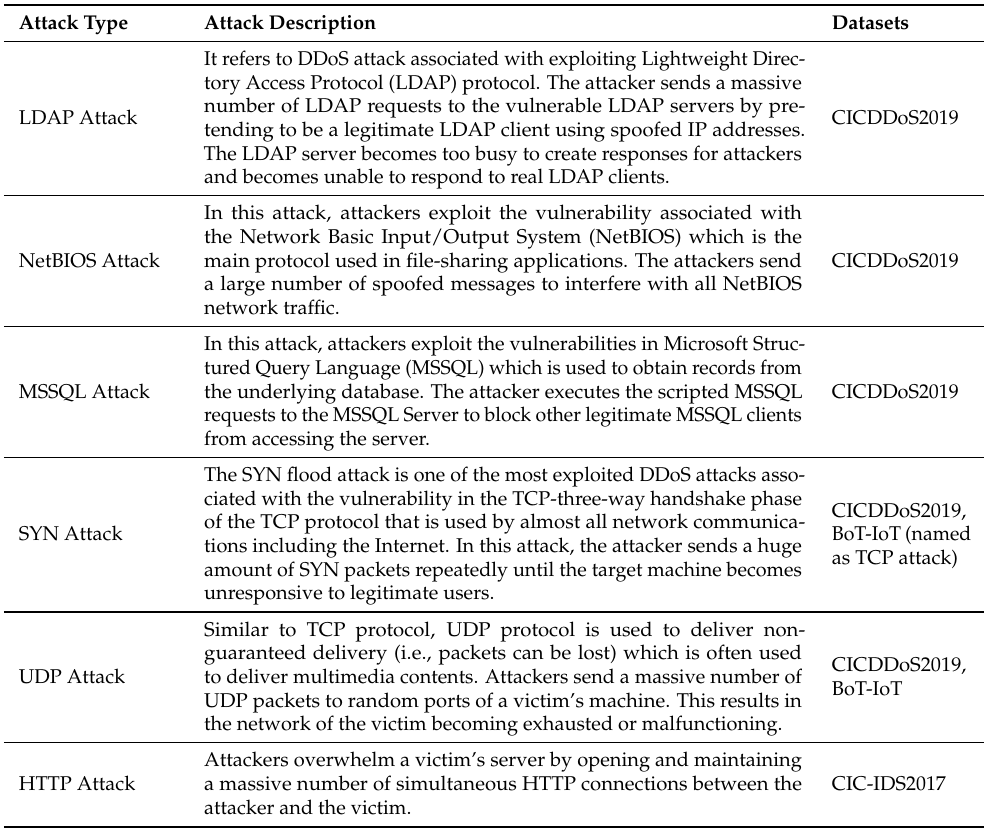
Table 3. Summary of DoS/DDoS attacks in our datasets and their